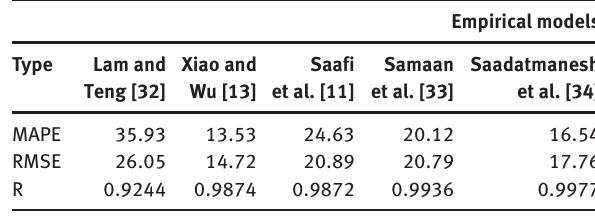
Table 11 Performance criteria of empirical models.